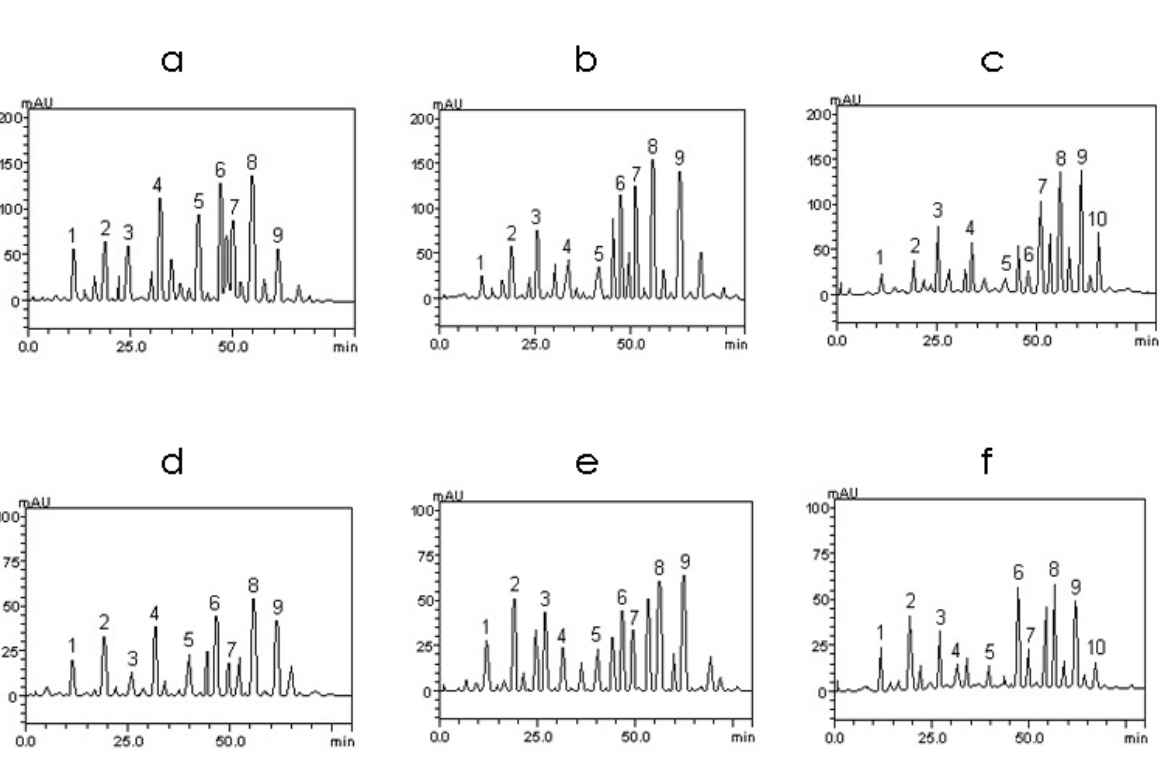
Figure 1. Representative HPLC profile of aqueous extracts of leaves and stems of Plectranthus barbatus : a) Infusion of fresh leaves; b) Infu- sion of dry leaves (microwave); c) Infusion of dry leaves (room temperature); (d) Decoction of fresh stems; e) Decoction of dry stems (microwave); (f) Decoction of dry stems (room temperature). UV detection at 327 nm. gallic acid (peak 1), boldine (peak 2), caffeic acid (peak 3), ellagic acid (peak 4), rutin (peak 5), quercitrin (peak 6), quercetin (peak 7), isoquercitrin (peak 8), kaempferol (9) and luteolin (peak